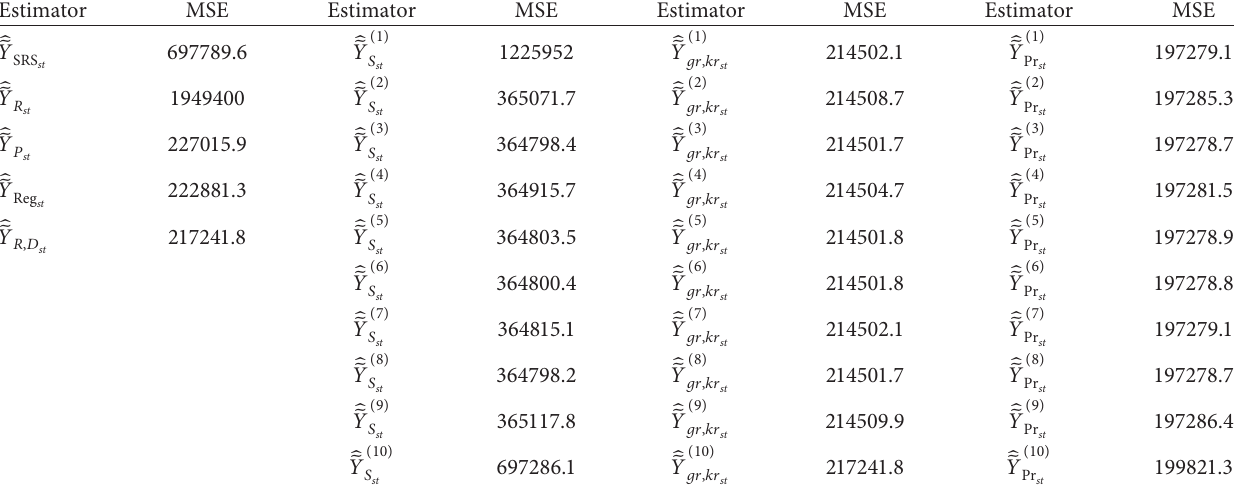
Table 8: MSEs using population 2 (scenario I).